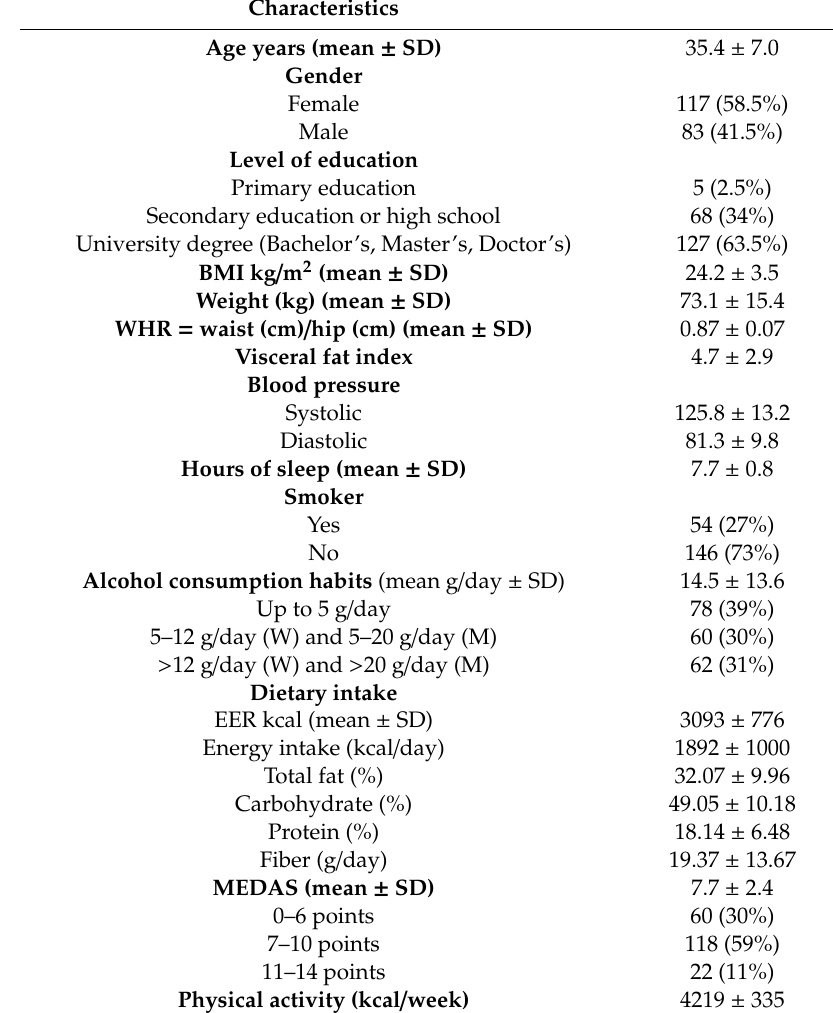
Table 1. Basic characteristics of the participants included in the study ( n =